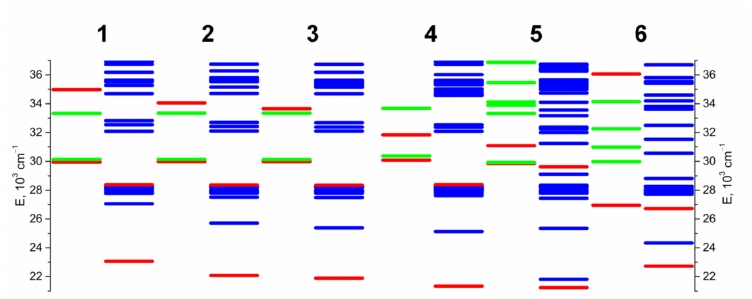
Figure 5. Energy level diagram of the excited states in 1 – 6 obtained from TDDFT calculations. Colour legend shows singlets (green), triplets (blue), and low-lying active states